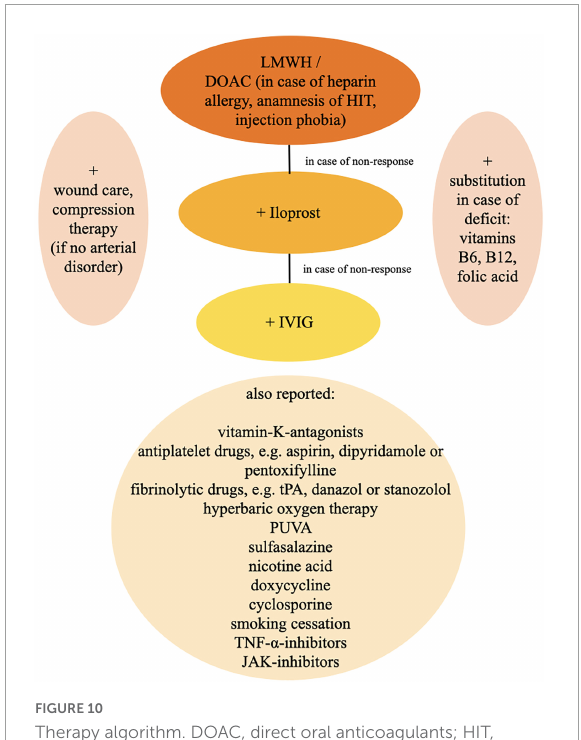
FIGURE10 Therapy algorithm. DOAC, direct oral anticoagulants; HIT, heparin-induced thrombocytopenia; IVIG, intravenous immunoglobulins; JAK-inhibitors, januskinase-inhibitors; LMWH, low-molecular-weight heparin; PUVA, psoralen plus UVA; TNF- α -inhibitors, tumor necrosis factor-alpha-inhibitors; tPA, tissue-type